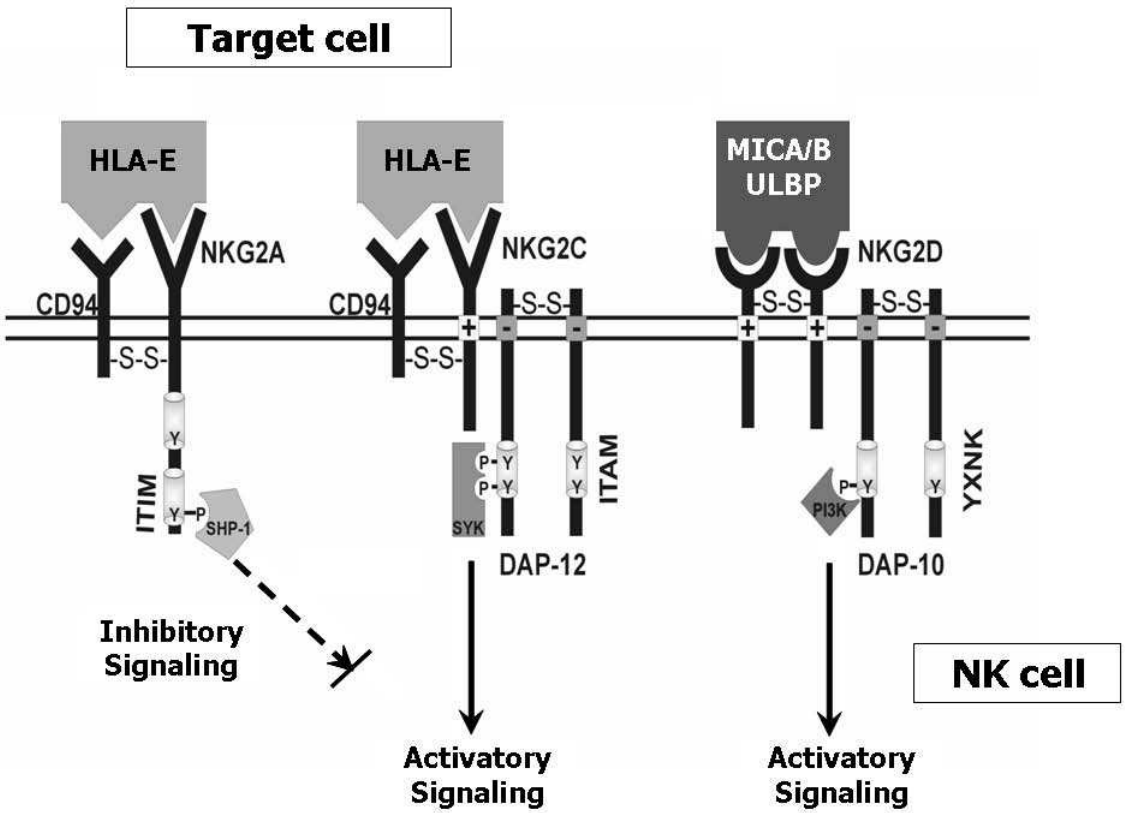
Fig. 1 Schematic representation of the operation mode of C-type lectin receptors in NK cells (adapted from [50, 55, 56]. C-type lectin receptors represent a heterogeneous group forming heterodimers of CD94 and certain members of the NKG2 family recog- nizing non-classical HLA-E molecules. CD94/NKG2A signals via tyrosine phosphatase SHP-1 through its SH2 domain enabling dephosphorylation of multiple targets in the ITIM-activating pathway resulting in negative